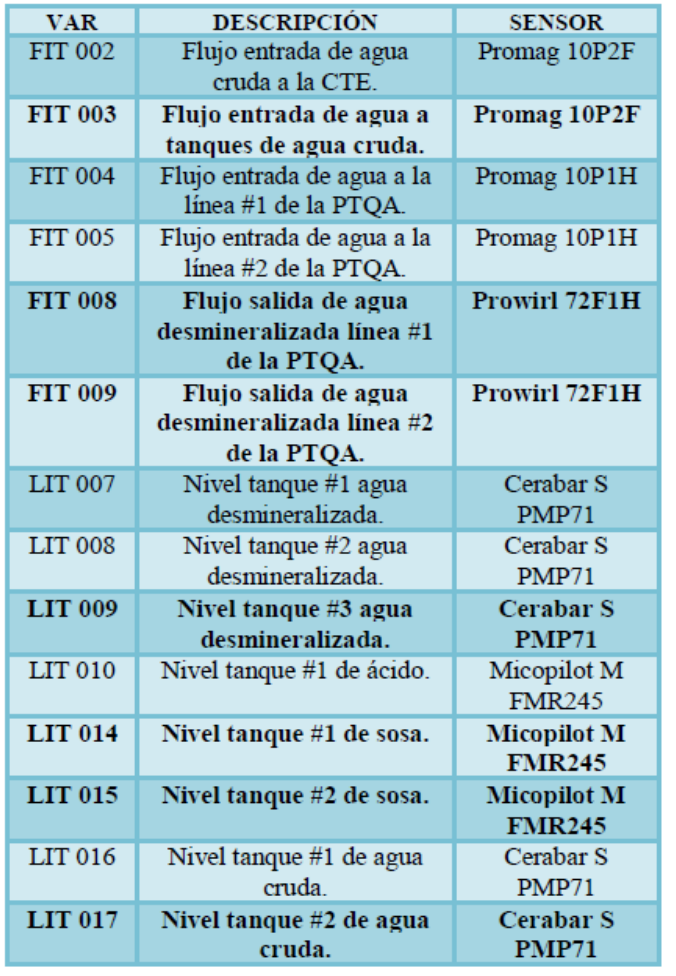
Tabla 3: Variables de la planta de tratamiento químico de agua.